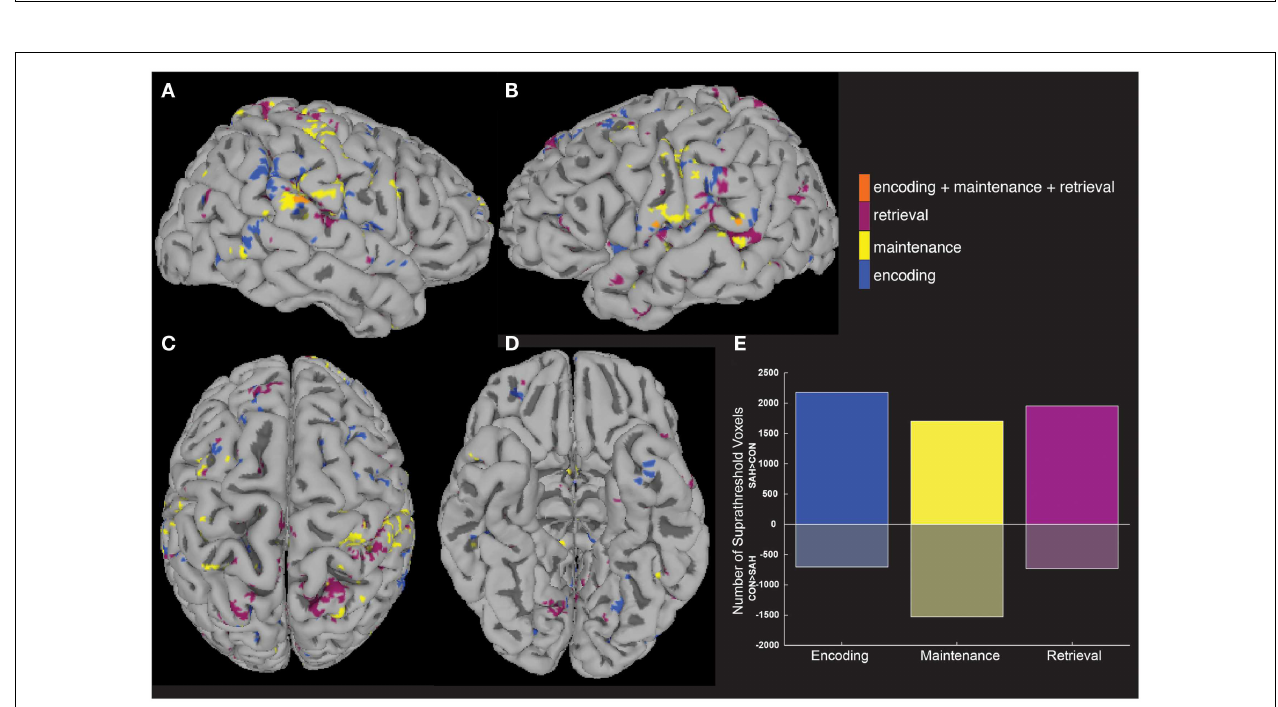
FIGURE 2 |Within-group analyses show distributed fMRI activity across working memory task periods . Separate mixed-effects model analyses indicate significant activity ( p < 0.05) across working memory encoding, maintenance (delay period), and retrieval task periods in the group of patients